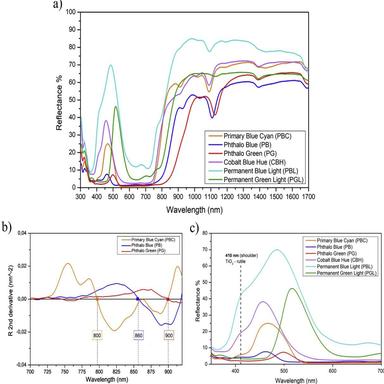
Reflectance spectra of Cu-Pc paints: a) in the 300–1700 nm spectral range; b) second derivative curves for PBC, PB and PG in the 700–920 nm range, where the zeros of the functions correspond to the position of the inflection points; c) zoom out of the reflectance spectra of Cu-Pc paints in the 350–700 nm. The shoulder at 410 nm highlights the presence of TiO2 only in PBC, CBH and PBL paints.